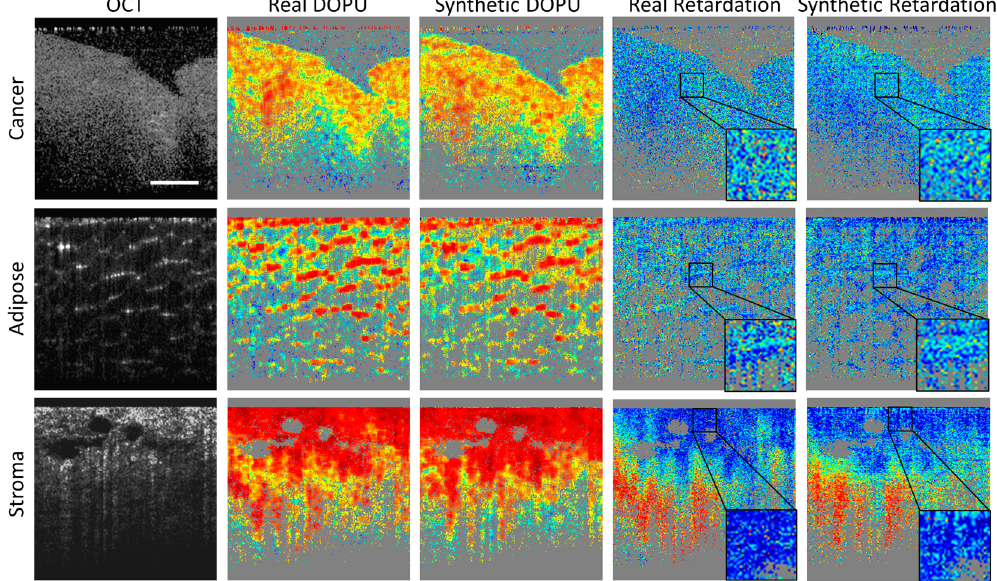
Fig. 2 Representative computational PS-OCT images from cancer, adipose, and stroma tissue specimens, compared with the real PS-OCT images. The noisy areas within the phase retardation images are enlarged to directly compare. The 200 μ m scale bar applies to all